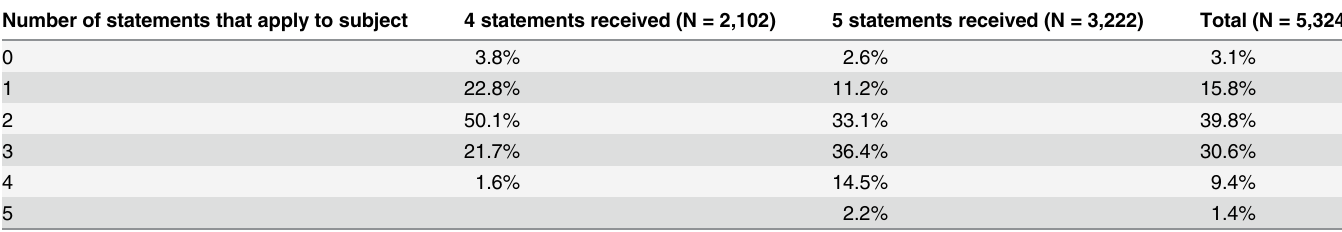
Table 1. Distribution of number of statements with which subjects reported to agree.